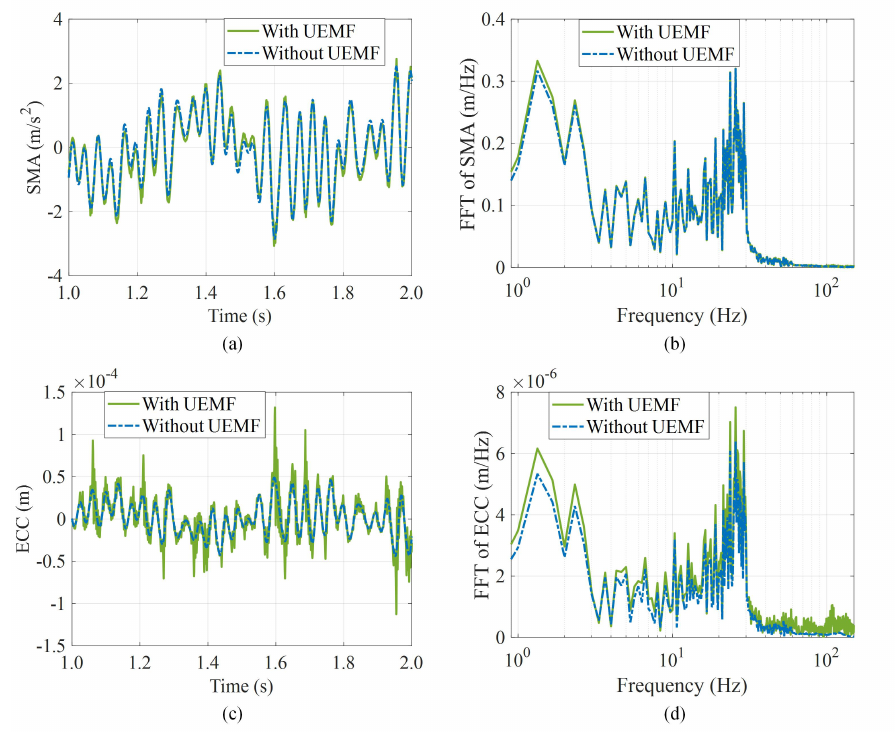
Figure 9. Coupling effects between the SMA, the ECC, and the UEMF: ( a ) the SMA time response; ( b ) the SMA frequency response; ( c ) the ECC time response; ( d ) the ECC frequency